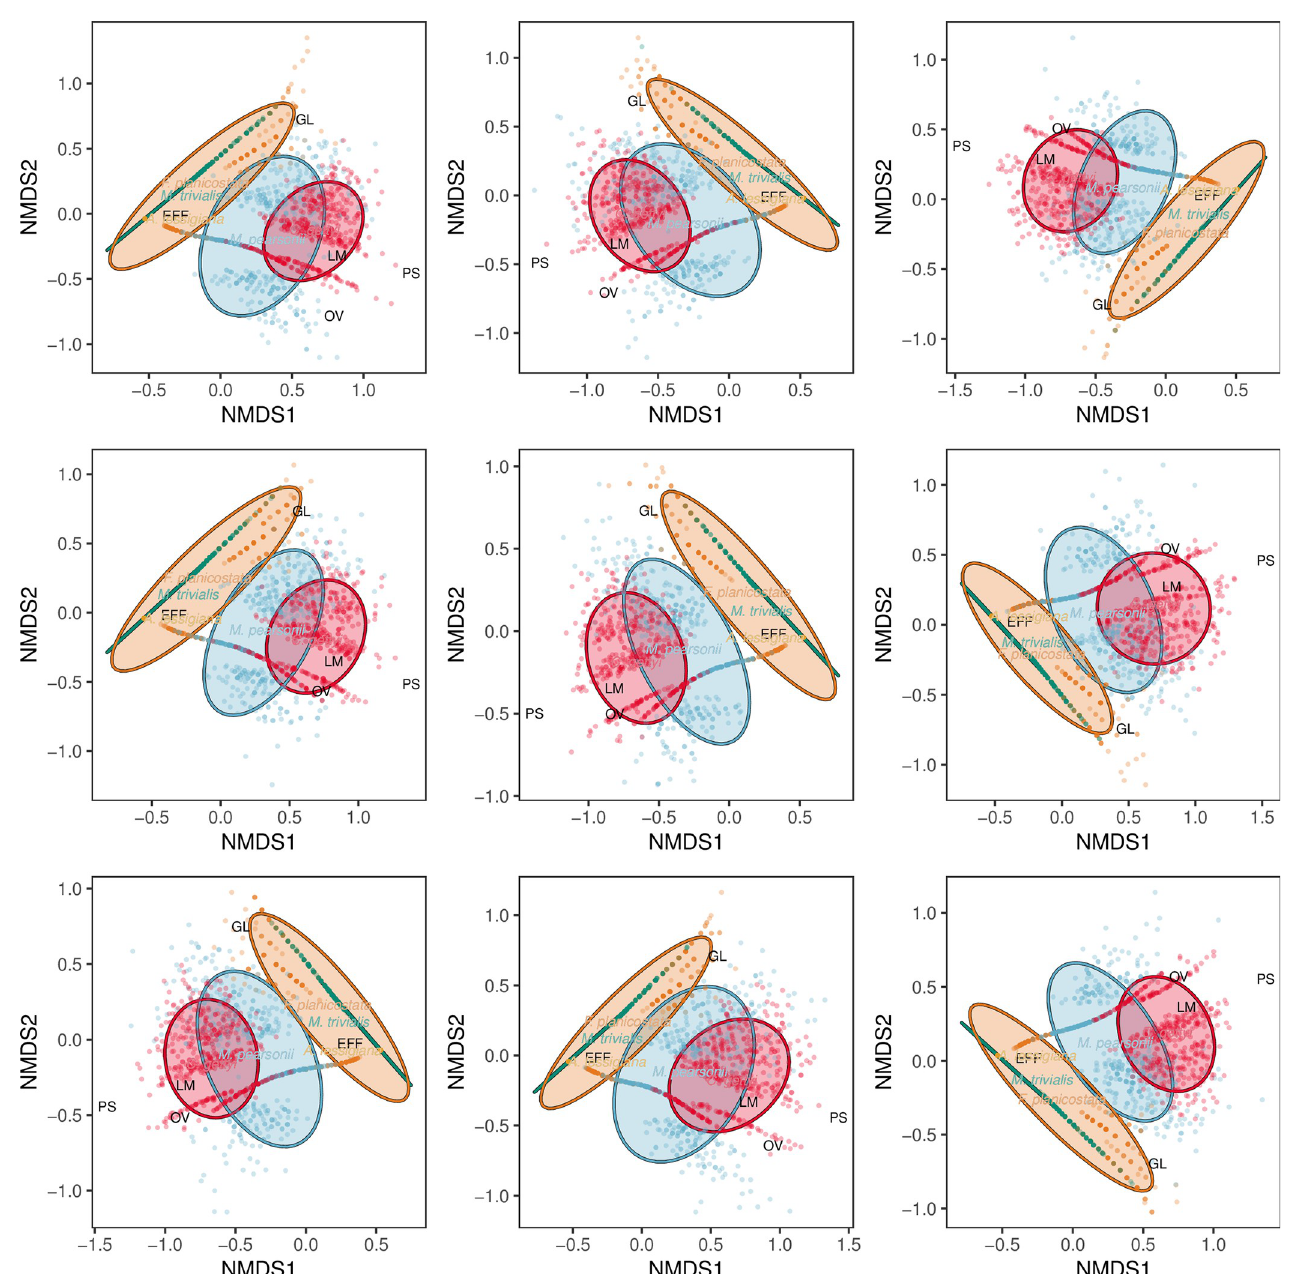
Fig 17. Non-metric multidimensional scaling (NMDS) ordination subsampled at 85,000 mm 2 . This ordination includes elipses, which denote 84% of the datapoints closest to the centroid, for Catula gettyi and the four Hell Creek taxa ( Marmarthia pearsonii , M . trivialis , “ Artocarpus ” lessigiana , and “ Ficus ” planicostata